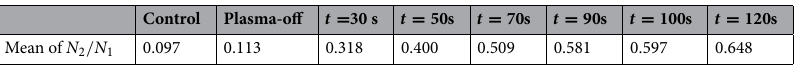
Table 2. The ratio of doublets to singles before and after treatment. As can be seen, this ratio increases after treatment, the longer the exposure time, the higher the ratio.